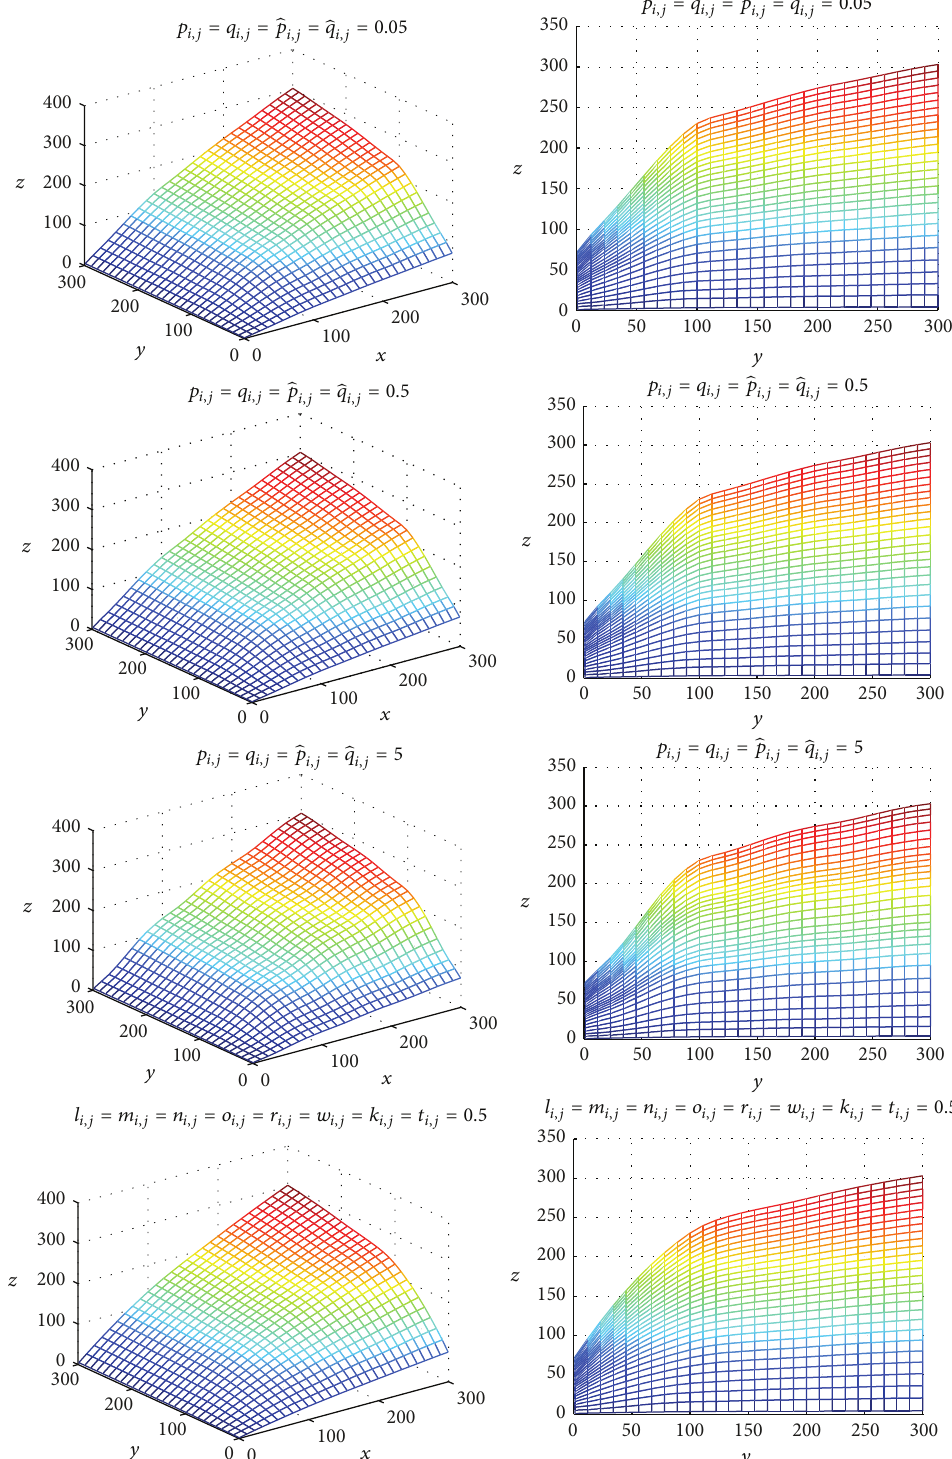
Figure 2: Surfaces created from the given monotonic surface data set in Table 2. The first three rows are our biquartic rational interpolation spline surfaces with different shape parameters, and the last row is the surface in [6] with given